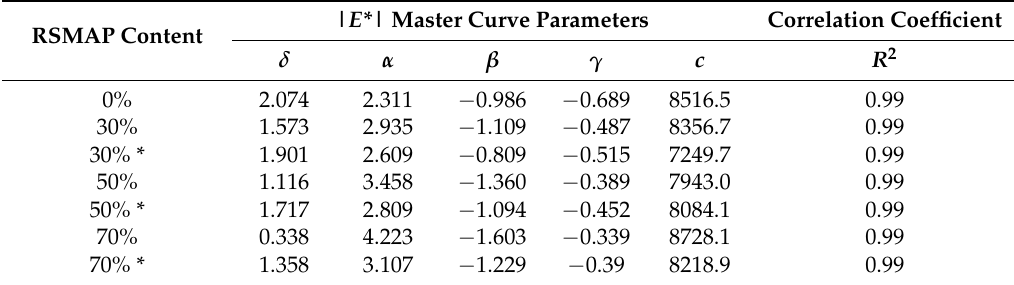
Table 12. Dynamic modulus master curve model parameters of recycled mixtures. RSMAP